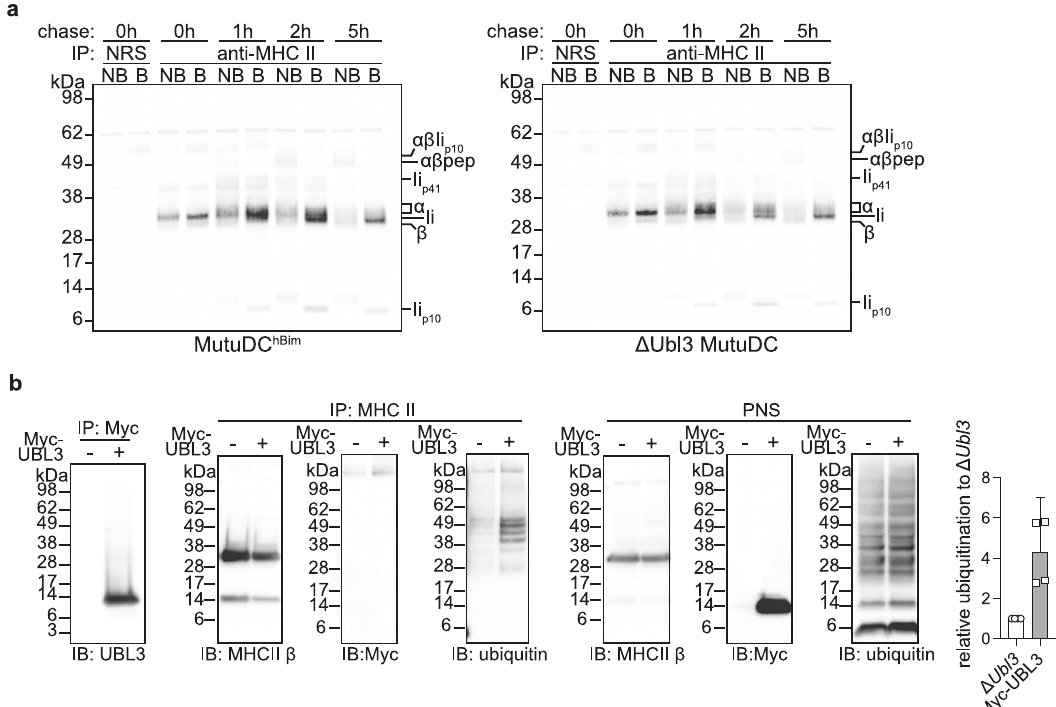
Fig. 2 UBL3 does not control MHC II via altering synthesis, peptide loading, or UBL3 modi fi cation of MHC II. a Analysis of Ii degradation and MHC II peptide loading in control MutuDCs expressing non-targeting hBim gRNA or Δ Ubl3 MutuDCs. Cells were metabolically labeled for 30 min, washed, and cultured in a growth medium for the indicated time points before lysis. MHC II molecules were immunoprecipitated with JV1 rabbit antisera, or normal rabbit serum (NRS), and protein G-Sepharose. Samples were loaded before (NB) or after boiling (B) at 95 °C ( b ), subjected to denaturing SDS-PAGE, transferred onto PVDF membranes, and exposed to a storage phosphor screen. Sizes corresponding to free MHC II α and β , full-length invariant chain (Ii), the Ii spliced variant Ii p41 , the degradation intermediate Ii p10 , and SDS-stable complexes αβ Ii p10 , and αβ -peptide (pep), are indicated on the right. Data from one experiment. b Δ Ubl3 MutuDCs or Δ Ubl3 MutuDCs expressing Myc-UBL3 were lysed and post-nuclear supernatants (PNS) were subjected to immunoprecipiation (IP) with anti-Myc-Tag agarose (clone 9E10) or anti-MHC II antibody (M5/114) crosslinked to protein G-sepharose. Per lane, samples equivalent to 5 × 10 6 cells (Myc IP), 2.5 × 10 6 cells (MHC II IP), or 400,000 cells (PNS) were analyzed by non-denaturing SDS-PAGE and western blotting using antibodies against UBL3 (ab113820), MHC II β chain (JV2), Myc (71D10), and ubiquitin (P4D1). Shown are representative blots and quanti fi cation of relative ubiquitination, with bars displaying mean + 95% con fi dence intervals for four